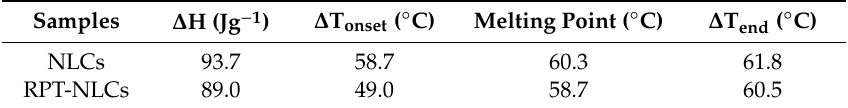
Table 6. Differential scanning calorimetry (DSC) parameters of NLCs and RPT-NLCs: melting Table 6. Di ff erential scanning calorimetry (DSC) parameters of NLCs and RPT-NLCs: melting enthalpy enthalpy ( Δ H), the onset, the melting point (peak maximum), and the end parameters. ( ∆ H), the onset, the melting point (peak maximum), and the end parameters.